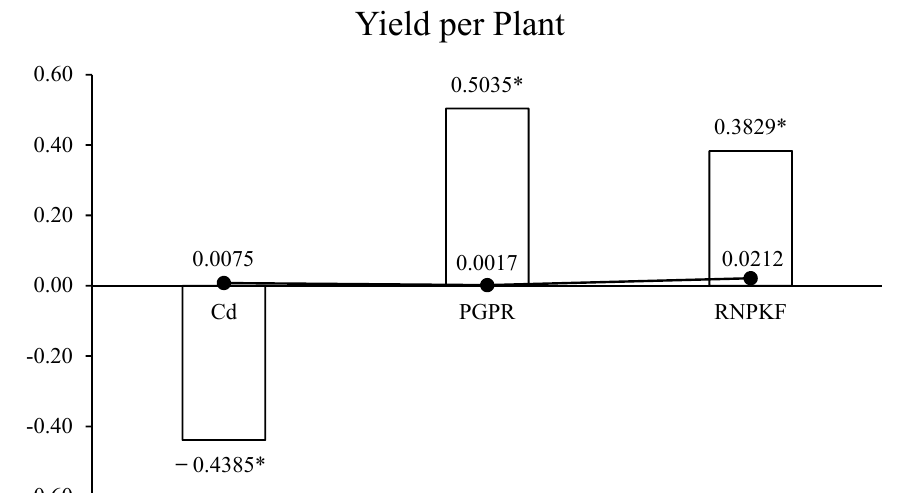
Figure 8. Pearson correlation of Cd, PGPRs, and RNPKF for yield per plant (YP)* = significant ( p ≤ 0.05); ns = non ‐ significant.